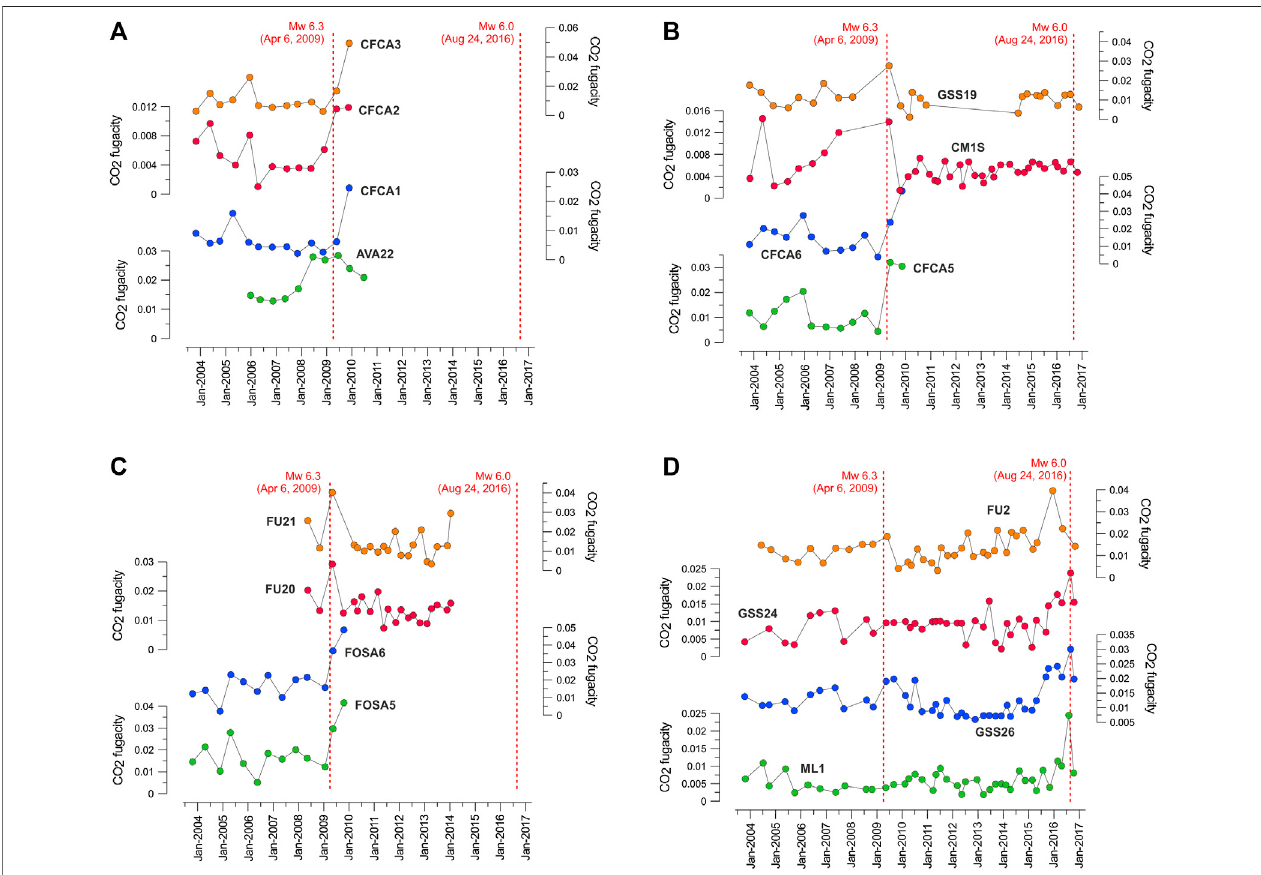
FIGURE2| Temporaltrends(2004 – 2017)ofP CO2 (fugacity)valuesforselectedspringsandwellsfromtheARPAnetworkofCentralItaly.Fromtheupperlefttothe right bottom, (A – C) : manifestations responsive to 2009 seismic events; (D) : manifestations responsive to 2016 seismic events.